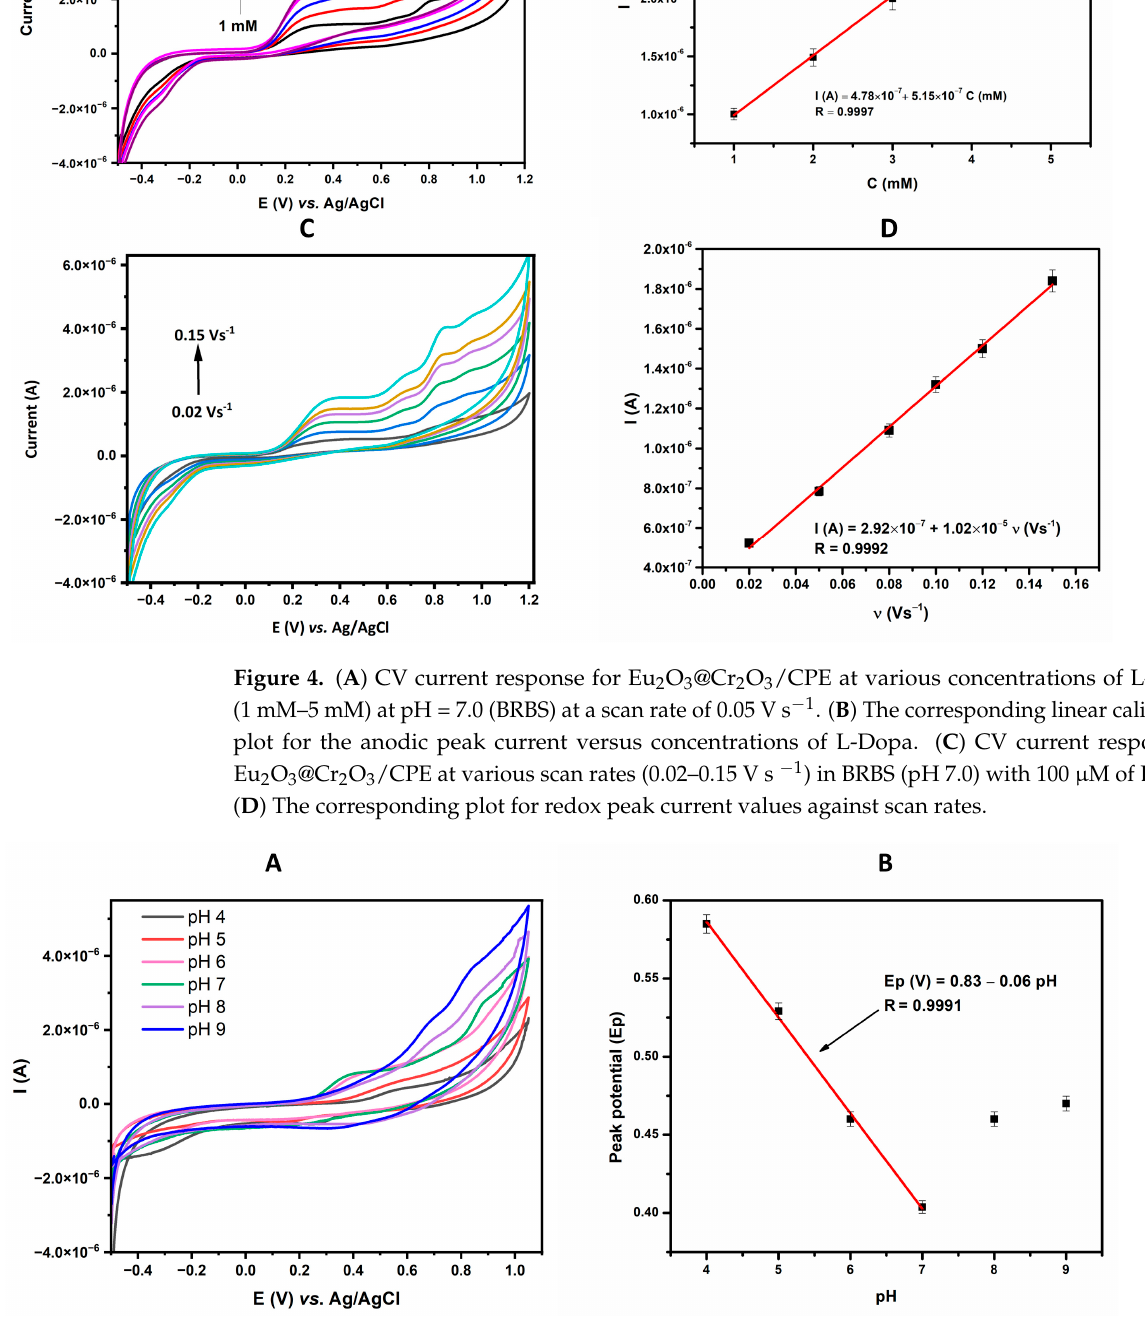
Figure 5. ( A ) CV current responses of Eu 2 O 3 @Cr 2 O 3 /CPE at various pH (4.0–7.0) of BRBS with 100 µM L-DOPA at a scan rate 0.05 V s − 1 . ( B ) The corresponding plot for oxidation peak potentials versus different pH (4.0–7.0).